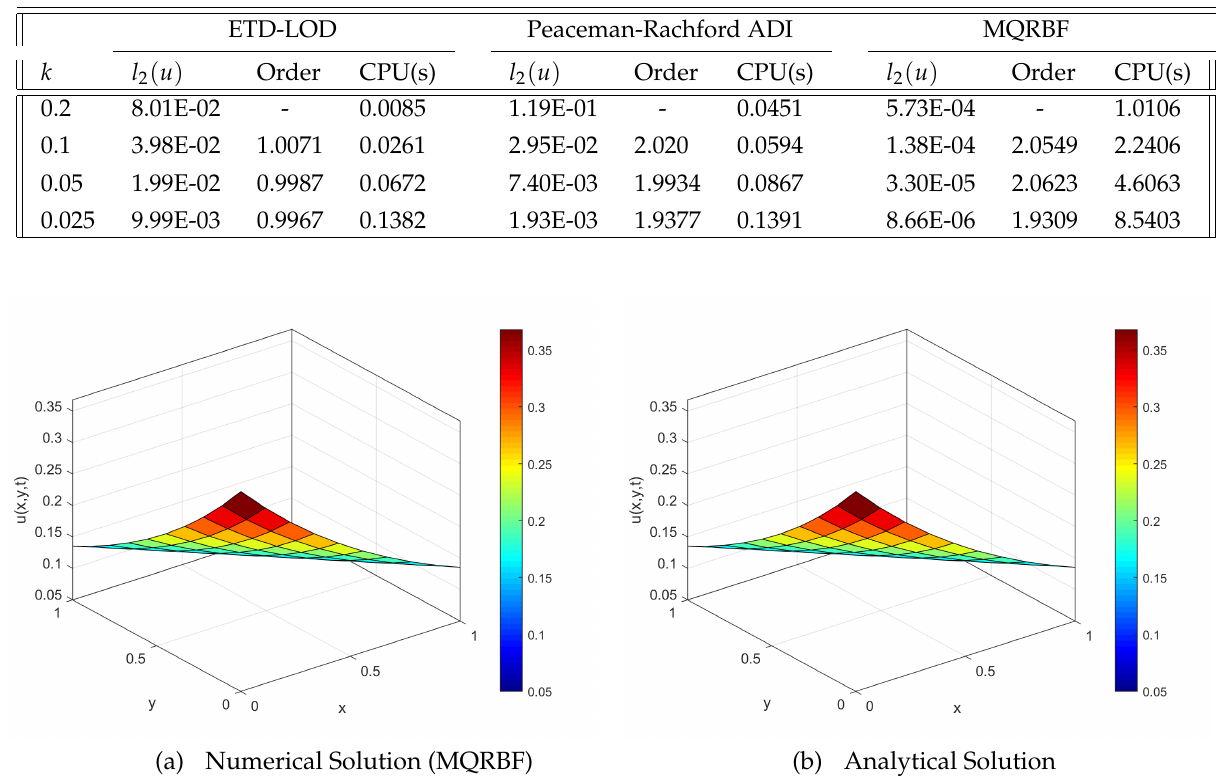
Figure 4. Comparison between solution profiles of u with h = 1/9, k = 0.01 at t = 2.